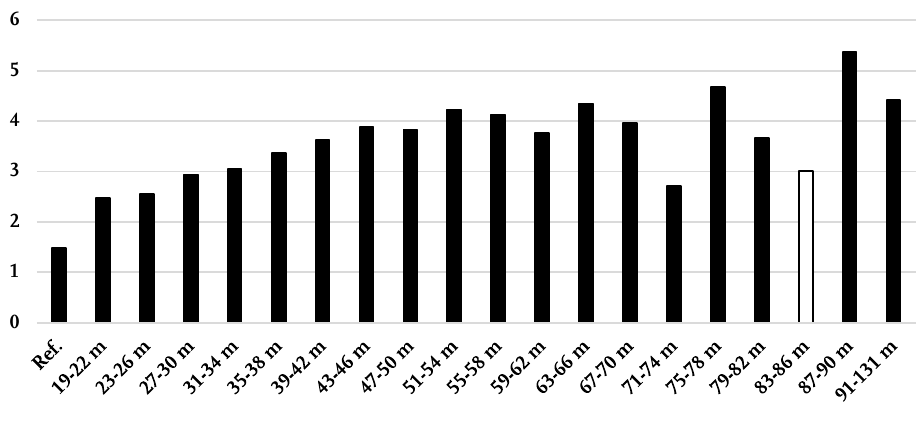
Figure 4 : The gap in income rank between first- and second-born siblings with different birth-spacing